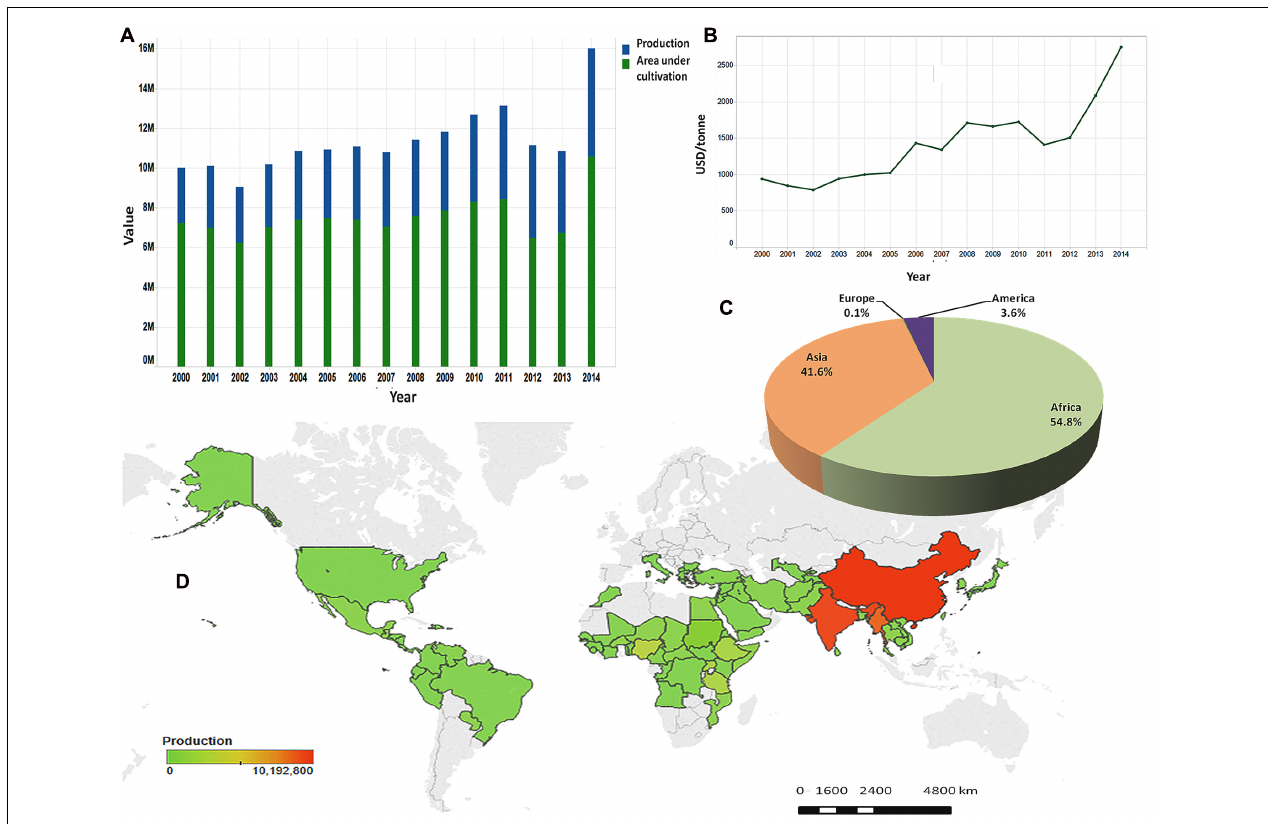
FIGURE 1 | Sesame seed production in the world. (A) Evolution of sesame seed production and area under cultivation from 2000 to 2014. (B) Evolution of sale prices of sesame seed from 2000 to 2014. (C) Production share of sesame seed by continent in 2014. (D) Map of production quantities of sesame seed by country based on cumulative data from 2000 to 2014. (Source: Food and Agriculture Organization Statistical Databases [FAOSTAT],